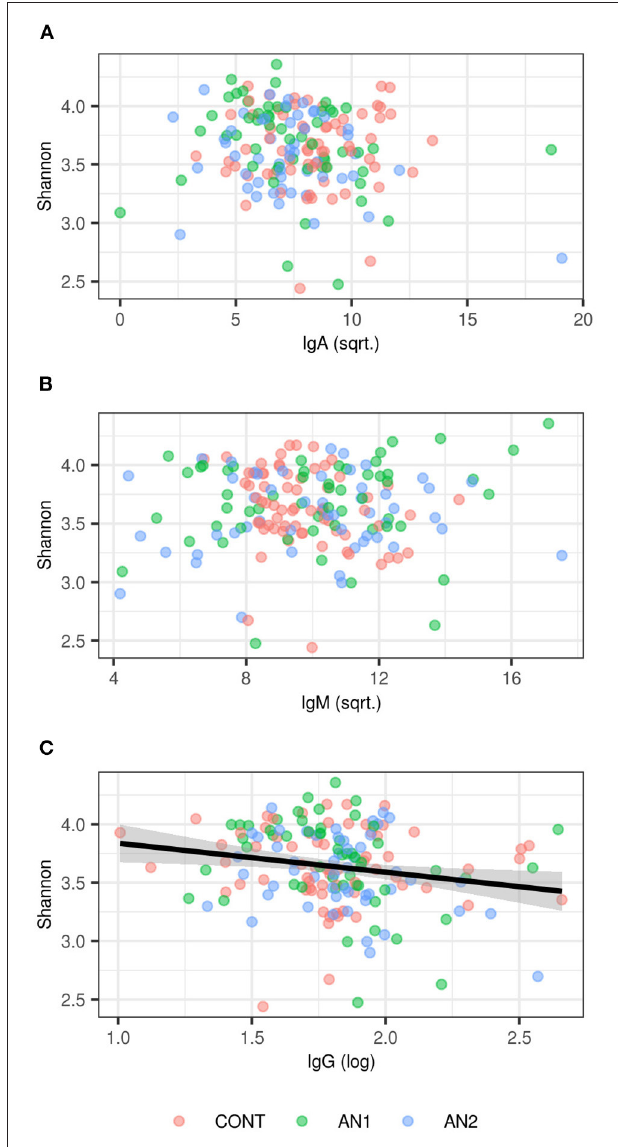
FIGURE 3 | Association between Shannon diversity and (A) anti- α -MSH IgA, (B) anti- α -MSH IgM, (C) anti- α -MSH IgG levels. LMM-based estimates and 95% confidence intervals are shown for significant association ( p <